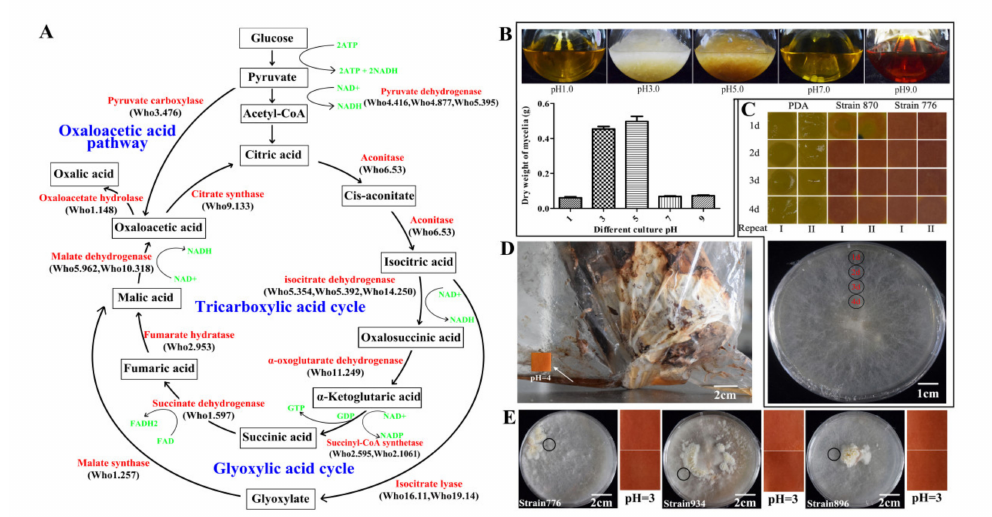
Figure 7. Oxalic acid synthetic pathway in Wolfiporia hoelen and the relationship of pH and the physiological process. ( A ) Oxalic acid synthetic pathway in W. hoelen ; ( B ) Mycelial growth condition and biomass under different pHs under liquid fermentation; ( C ) pH of PDA media on different days after mycelial growth; ( D ) pH of secretion in sclerotia formation; ( E ) pH of media in fruiting. The circles indicate the sites where the samples were taken and pHs were